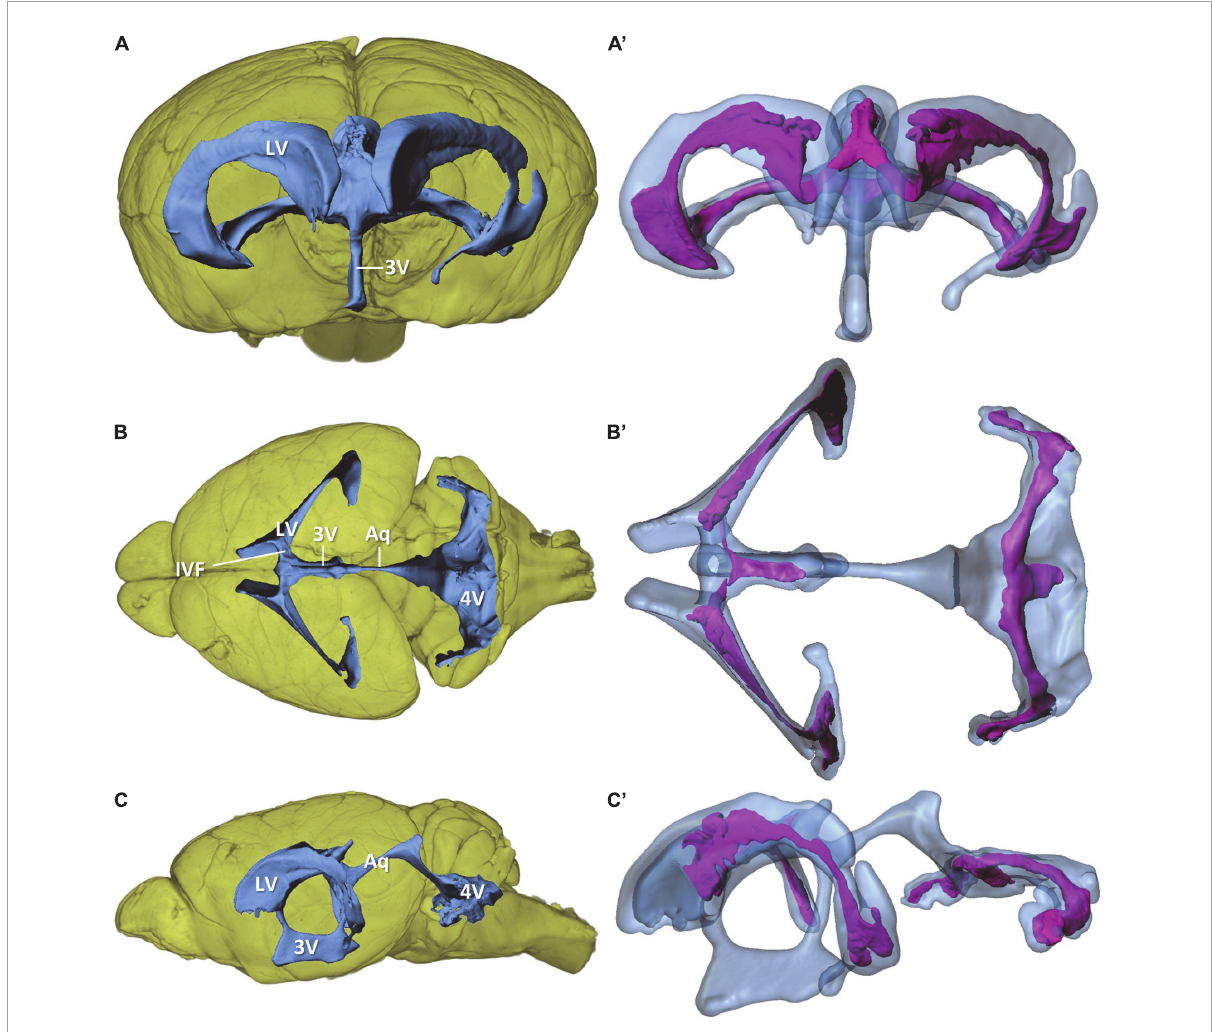
FIGURE1 Overview of the murine ventricular system and the choroid plexus within the ventricles. Volume rendering of the mouse brain (yellow) with surface models of the ventricular system (blue) and choroid plexus (purple) based on micro-computed tomography scans of a mouse brain. (A,A’) View from rostral; (B , B’) view from dorsal, (C,C’) view from lateral. 3V, third ventricle; 4V, fourth ventricle; Aq, aqueduct; IVF, interventricular foramen; LV, lateral